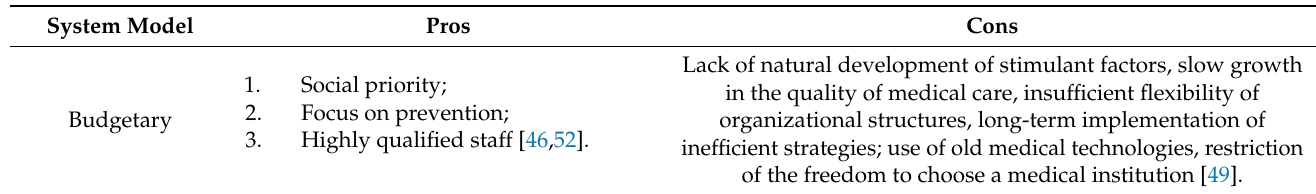
Table 3. Comparative characteristics of models of healthcare system in